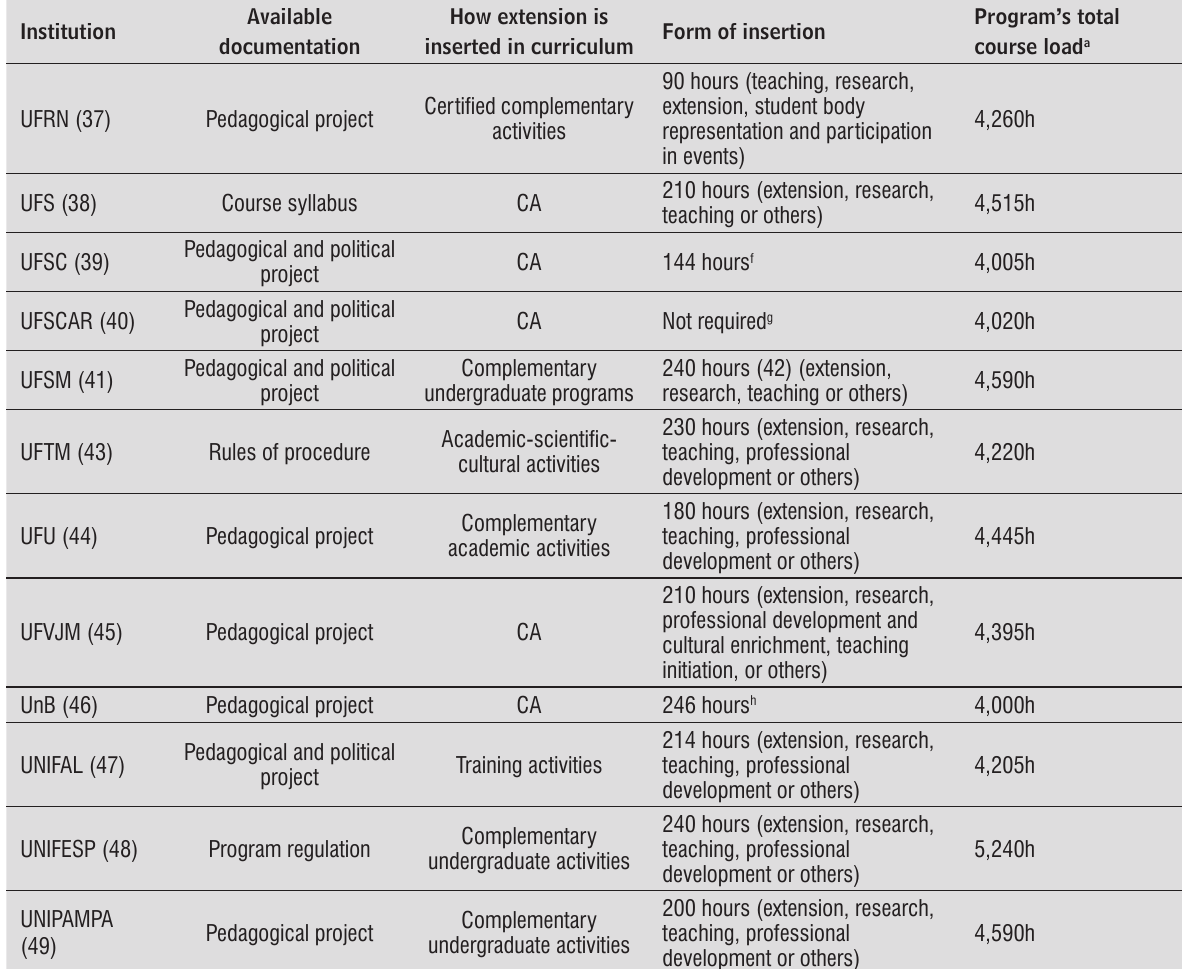
Table 2 - Distribution of federal institutions that offer physical therapy programs, type of documentation used, and how extension activities are inserted in the undergraduate